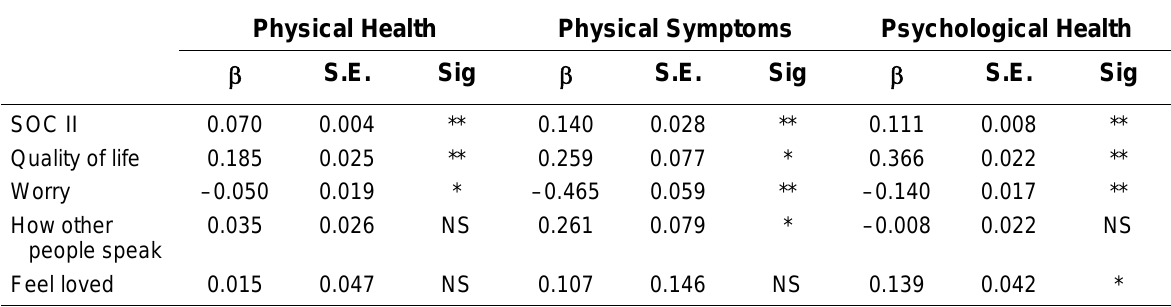
Model 4 (Attitude Variables), Linear Regression Analysis with Health as the Dependent